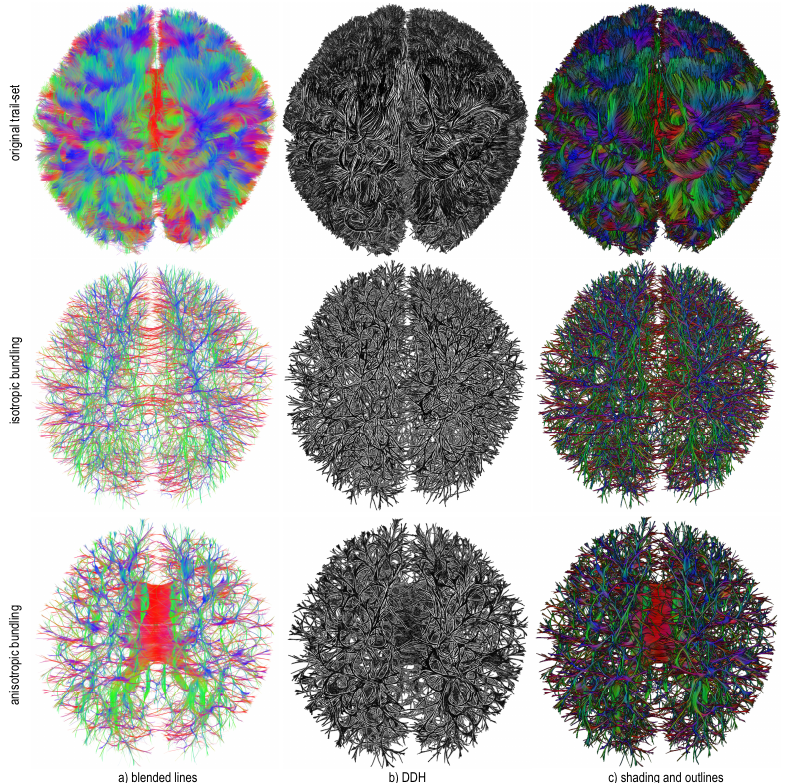
Figure 13. Comparing four rendering modes for a large 250 K full-brain trail set. Original unbundled data ( top row ) and its bundled counterpart ( bottom row ). See Section 5.